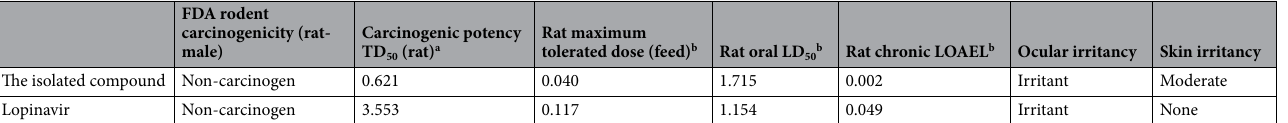
Table 5. The isolated compound’s toxicity properties. a Unit: mg/kg body weight/day. b Unit: g/kg body